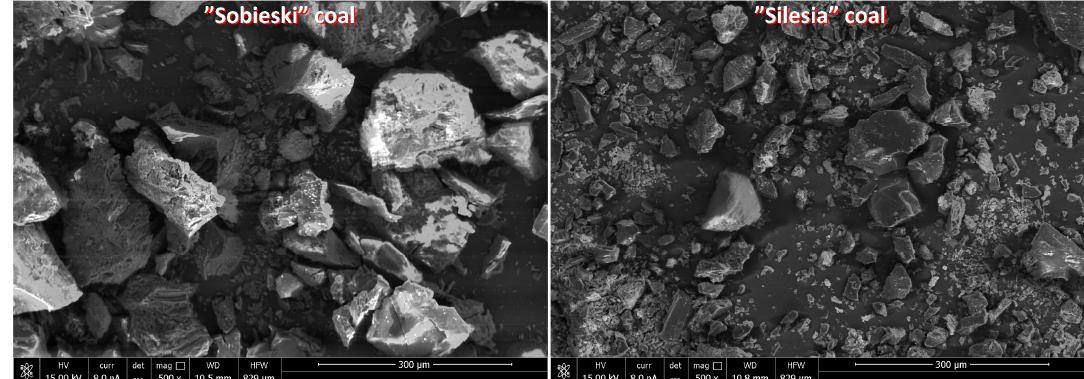
Figure 3. SEM images (magn. 500×) of the microstructure of the surface of coal briquette. The results of low-pressure nitrogen adsorption analyses (LPNA method) at tempera- ture of 77 K, as well as pore size distribution of both coal samples, are presented in Figure 4. These tests were performed on the ASAP2020 analyser (Micromeritics). The obtained sorption capacity of “Sobieski” coal was about twice as high as that of the “Silesia” sample. The maximum quantity of adsorbed of the “Sobieski” coal was 12.37 cm 3 /g, and of the “Silesia” coal 7.08 cm 3 /g, at the relative pressure p / p 0 = 1.